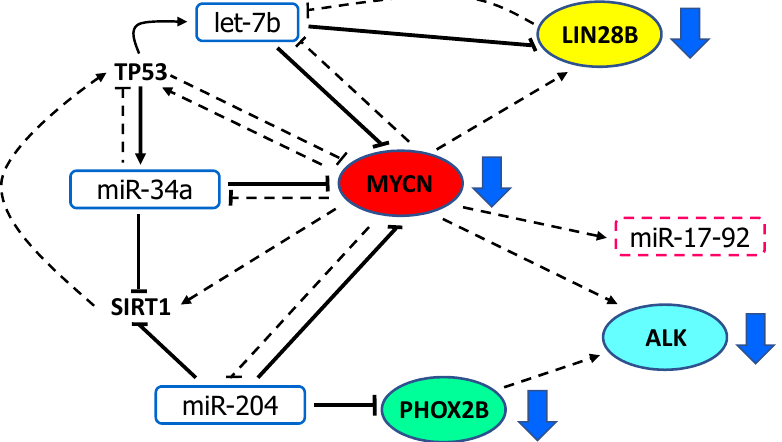
Figure 3. Physiological interactions between miR ‐ 34a, let ‐ 7b, miR ‐ 204, the transcription factors MYCN and PHOX2B and their target genes ALK and LIN28B through feedback and coherent feed ‐ forward loops. During physiologic regulation, miR ‐ 34a, let ‐ 7b and miR ‐ 204 exert effective down ‐ regulation of MYCN, PHOX2B and LIN28B (bold inhibitory lines) through feedback and coherent feedforward loops. In turn, MYCN and PHOX2B carry out a controlled activation of the transcrip ‐ tion of their target genes (dashed arrows). The effect of MYCN activity over its targets and of LIN28B repression of let ‐ 7 biogenesis are also under control (dashed inhibitory lines). All three miRNAs are engaged with the TFs in feedback and coherent feedforward loops and the global effects are the reduced levels of all proteins encoded by target genes (large blue arrows).